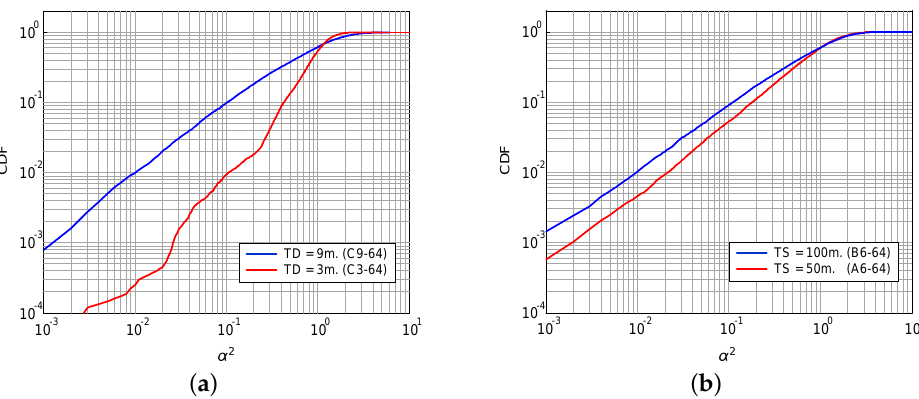
Figure 5. Cumulative distribution function (CDF) of the power gain estimated from measurements: ( a ) for two different transducers’ depth and the same link distance (200 m) and sounding frequency (64 kHz); ( b ) for two different link distances and the same transducers’ depth (6 m) and sounding frequency (64